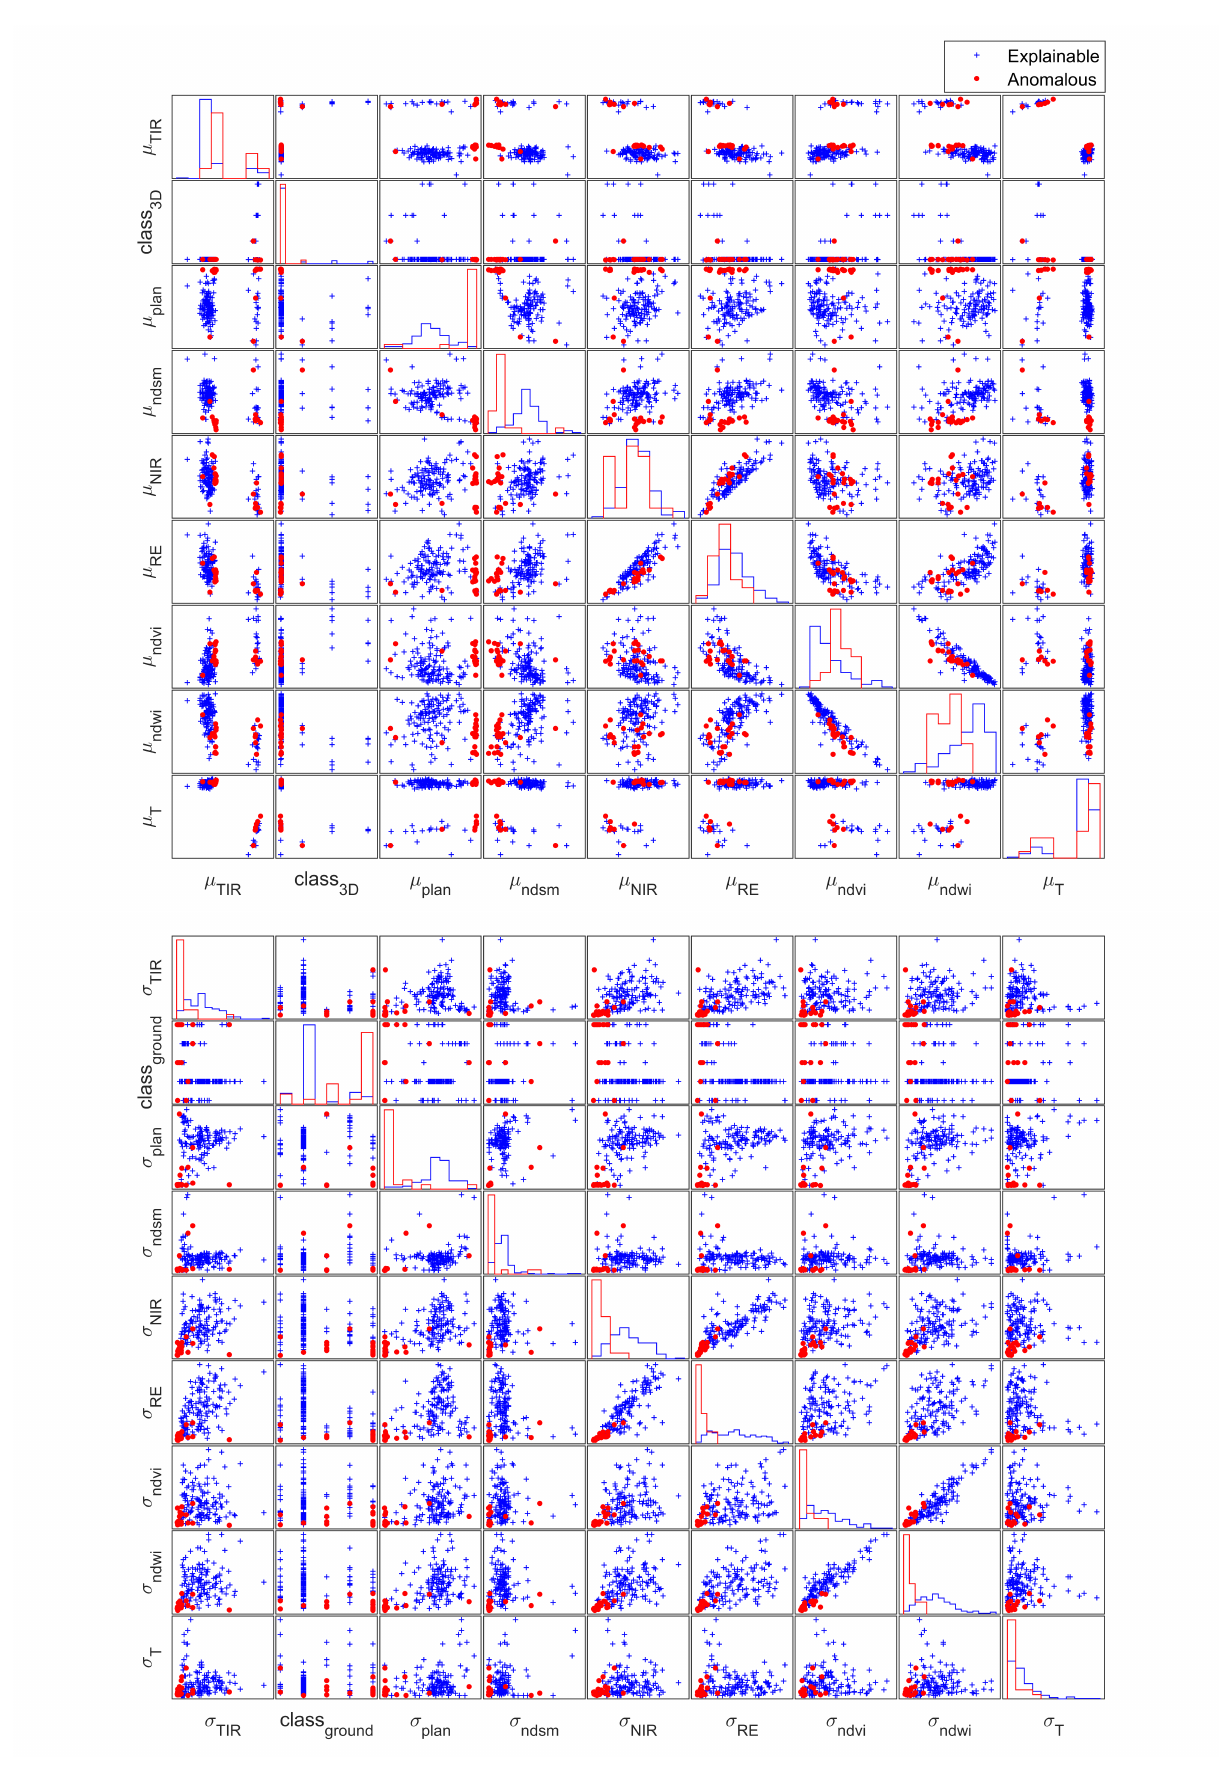
Figure 6. Scatterplot matrix of means and standard deviations of the features: measured aerial TIR image, land-cover segmentation map class ground , projected semantic class image class 3D , planarity map plan , NDSM, NIR image, RE image, NDVI, NDWI, and simulated surface temperature